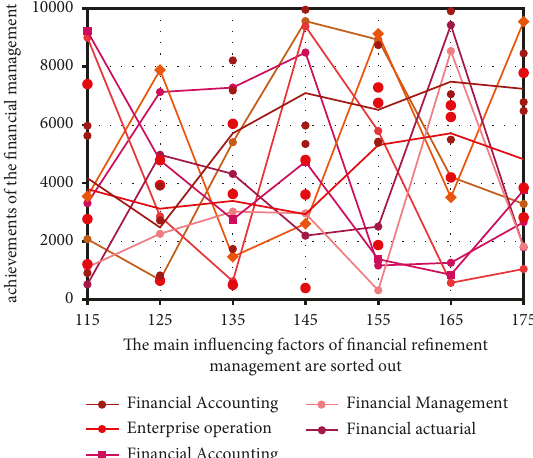
Figure 7: The main influencing factors of financial refinement management are sorted